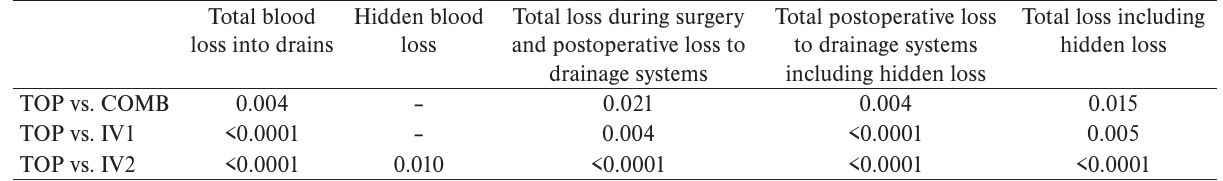
Table 3. Comparison of blood loss in individual TXA regimens (results of Dunn’s post hoc test). Total